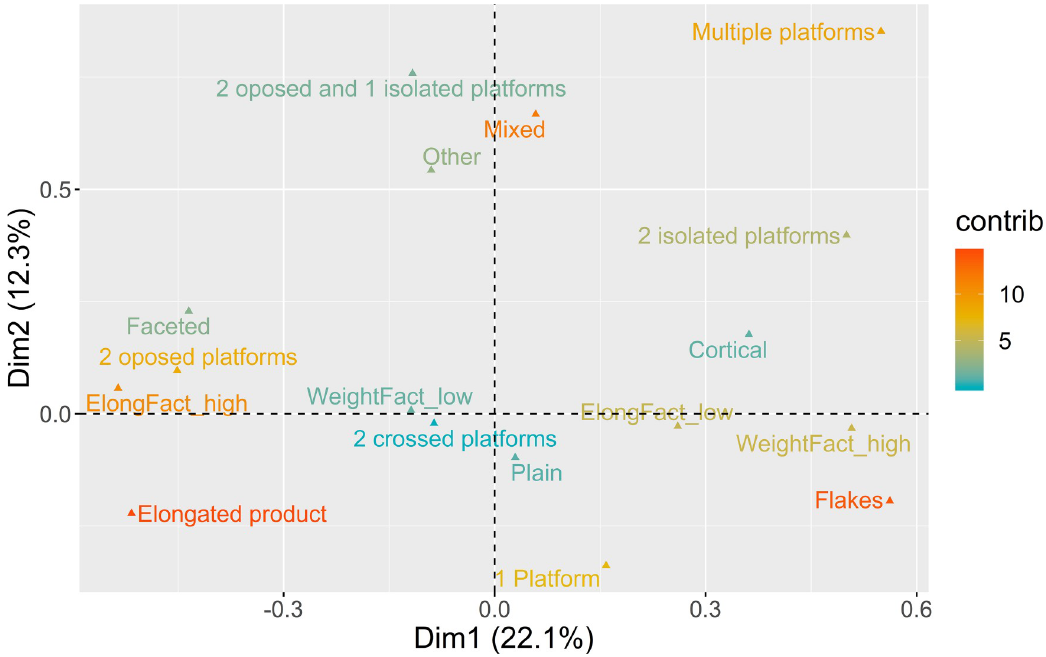
Fig 15. Multiple correspondence analysis plot (first two dimensions) for core use. The color ramp represents the contribution (in %) of the variable categories to the definition of the dimensions.